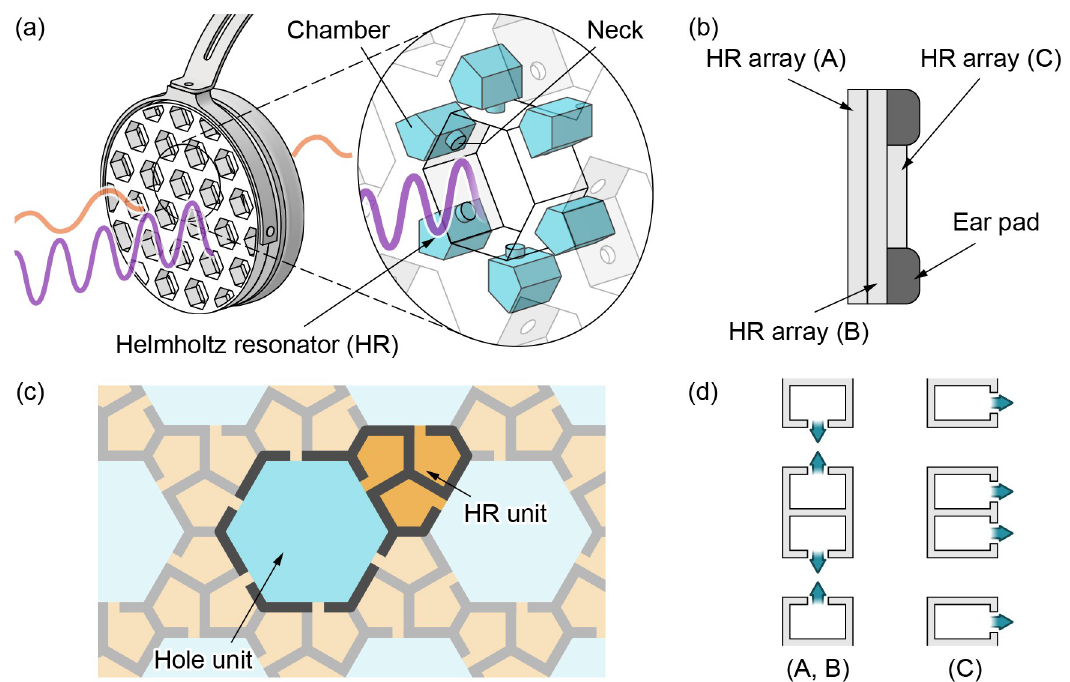
Fig 1. (a) Conceptual diagram of the device. Each HR structure is a chamber with a neck-shaped orifice (neck). Six parallel HRs are placed around each hole. The cancellation of waves from the HRs insulates noise at a specific frequency. (b) Cross-sectional view of the device. The device comprises an ear pad and three HR array plates for both the right and left ears. (c) Schematic diagram of the HR array unit structure. An HR array consists of regular hexagonal penetration hole units and hexagonal parallelogram HR units. An HR unit is an aggregation of three identical HRs. (d) Two HR array (A, B) plates insulate the sound waves entering perpendicularly to the plates, while the last HR array (C) plate insulates the sound waves entering parallel to the plates.